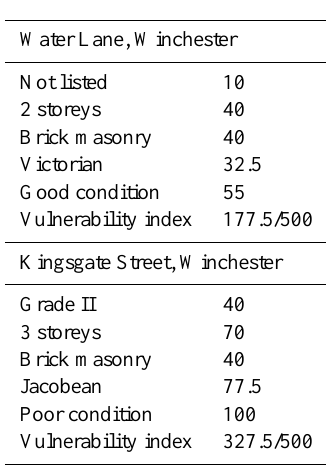
Table 3. Winchester vulnerability index comparison.